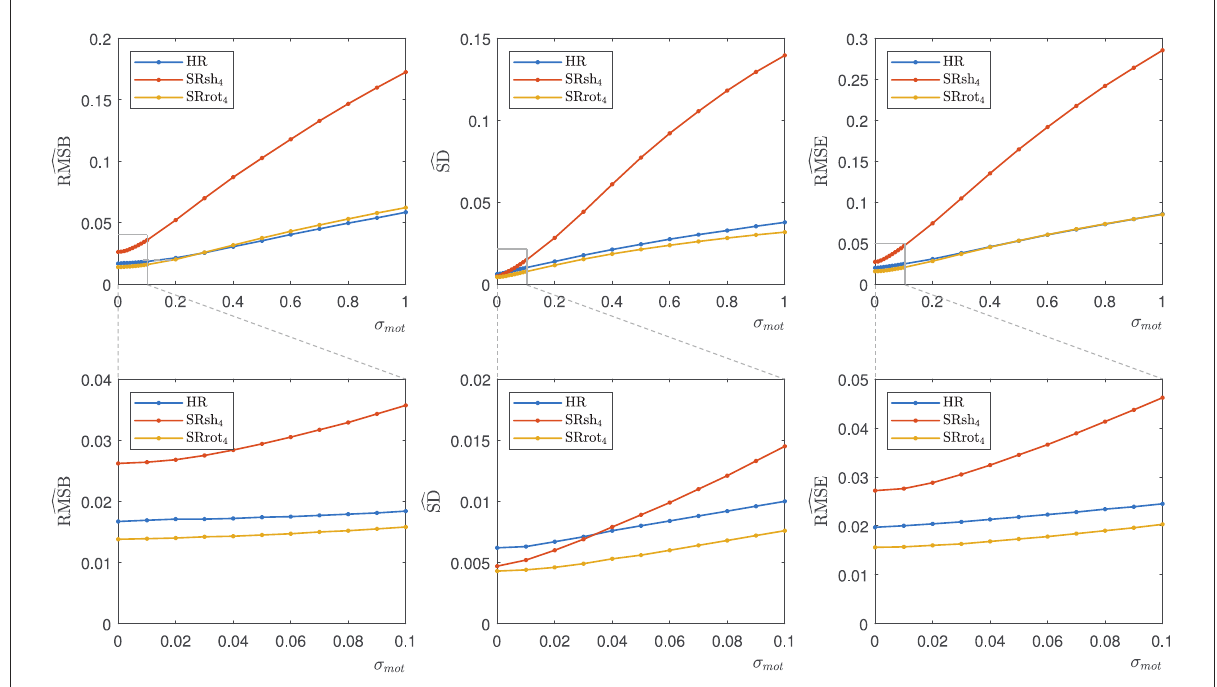
FIGURE9 Retrospective simulation results: \ RMSB, SD, and [ RMSE median values. The median values were calculated for each parameter from the respective parameter map within a brain mask in the absence of motion ( σ mot c σ mot (0.1 mm / ◦ 1 mm / ◦ ) levels of inter-image motion. The bottom row shows a zoomed plot corresponding to the indicated ≤ ≤